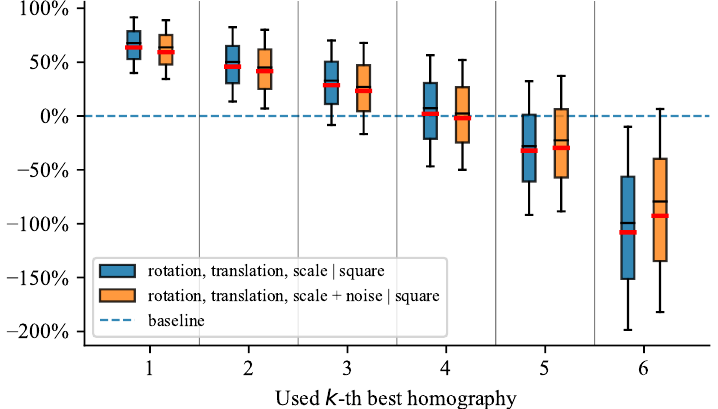
Figure 7. Influence of noise applied to the warped keypoints representing a noisy point